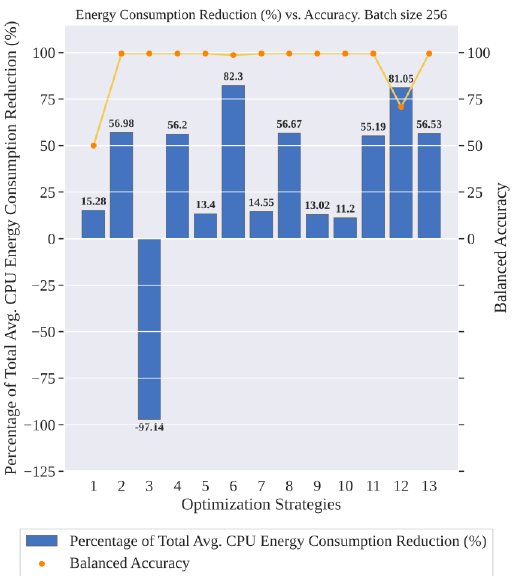
Figure 9. Energy consumption reduction obtained with each optimization strategy in the inference phase with respect to the non-optimized model using a batch size of